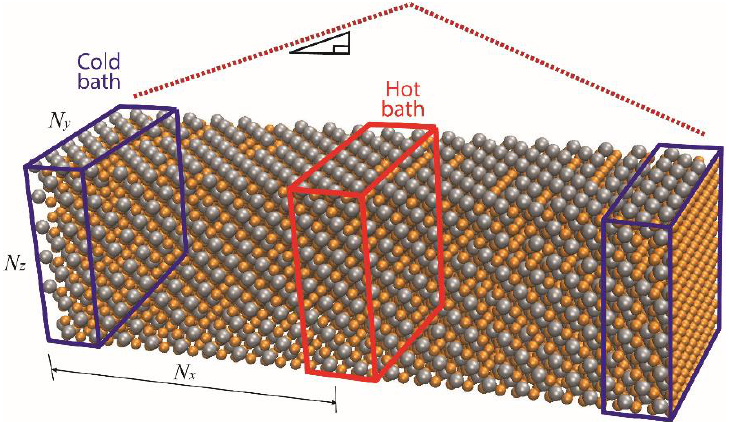
Figure 1. Actinide oxide structure with vacancy defects during RNEMD. RNEMD induces a temperature gradient by imposing a heat flux between the hot bath and the cold bath.